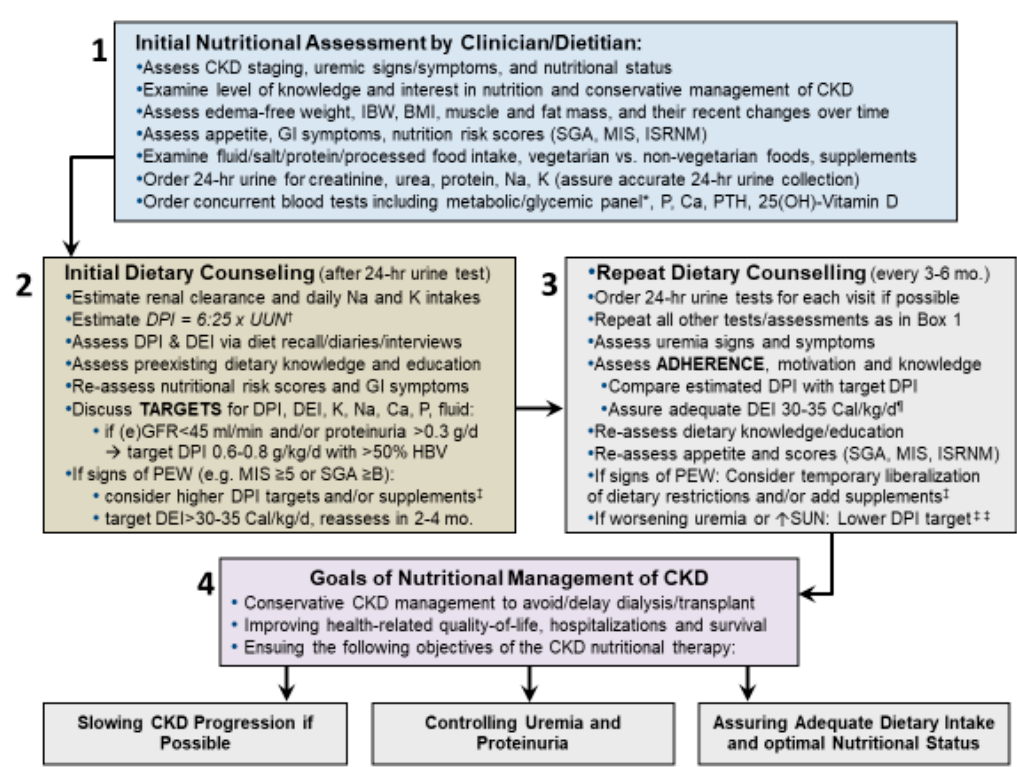
Figure 4. An algorithm and steps for the approach to the nutritional management of patients with CKD. Note that in addition to direct dietary assessments, periodic 24-h urine collections should be used to estimate dietary protein, sodium, and potassium intakes in order to assess adherence to dietary recommendations (adapted from the Supplementary-Appendix-Figure S4. Under Kalantar-Zadeh and Fouque, N Engl J Med. 2017) [25]. * Comprehensive metabolic and glycemic panels include electrolytes, SUN, creatinine, glucose, hemoglobin A1c, liver function tests, and the lipid panel. † The full equation is: DPI = 6:25 × UUN + 0:03 × IBW † Add the amount of daily proteinuria in grams if proteinuria > 5 g / d. Calculate the creatinine index (24-hr urine creatinine divided by actual weight or IBW if obese) and compare it to the expected value of 1–1.5 g / kg / d for women and 1.5–2 g / kg / day for men. ‡ Dietary supplements can be added to provide additional sources of energy and / or protein including—but not limited to—CKD specific supplements, essential amino-acids, or keto-analogues (ketoacids) of amino-acids. ¶ To ensure adequate DEI of at least 30–35 Cal / kg / d, higher fat intake can be considered, e.g., non-saturated fats, omega 3-rich flaxseed, canola, and olive oil. ‡‡ If worsening uremic signs and symptoms occur, DPI < 0.6 g / kg / d with supplements can be considered. Abbreviations: BMI: